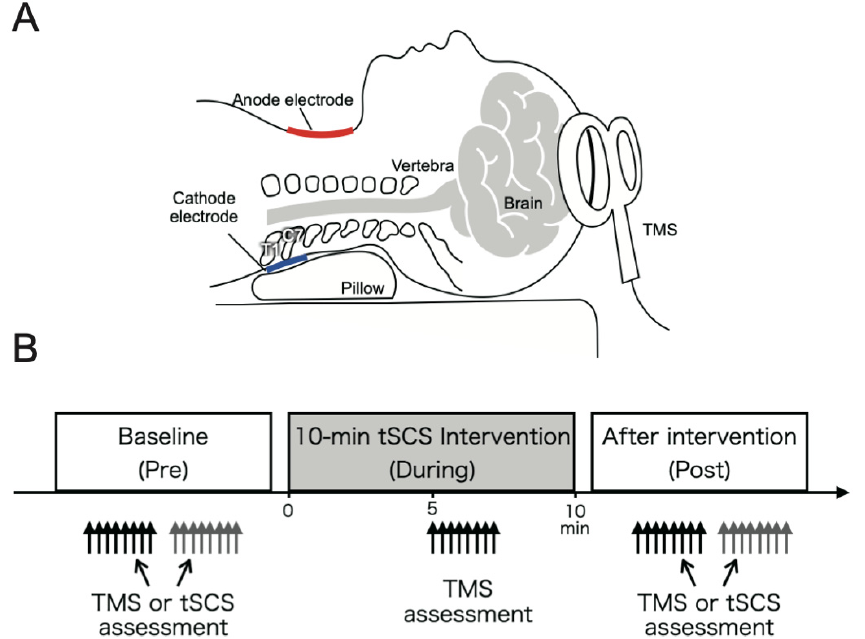
Figure 1. ( A ) Experimental setup showing head posture of participants during the experiments, including the cervical transcutaneous spinal cord stimulation (tSCS) setup and transcranial magnetic stimulation (TMS) setup. ( B ) TMS assessments were conducted before (Pre), during continuous cervical tSCS (During), and after (Post) the intervention, while tSCS assessments were conducted at Pre and Post intervention time points. At each assessment point, TMS or tSCS stimuli consisted of 8 elicited responses. In the Pre and Post assessment, the order of TMS and tSCS assessments was randomized between participants.